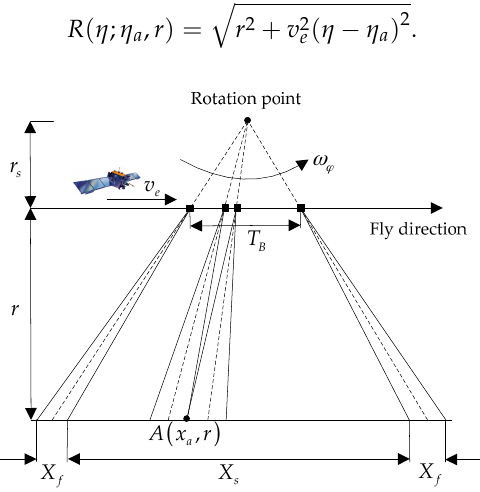
Figure 2 . Acquisition geometry of the TOPS mode in the slant range plane. Figure 2. Acquisition geometry of the TOPS mode in the slant range